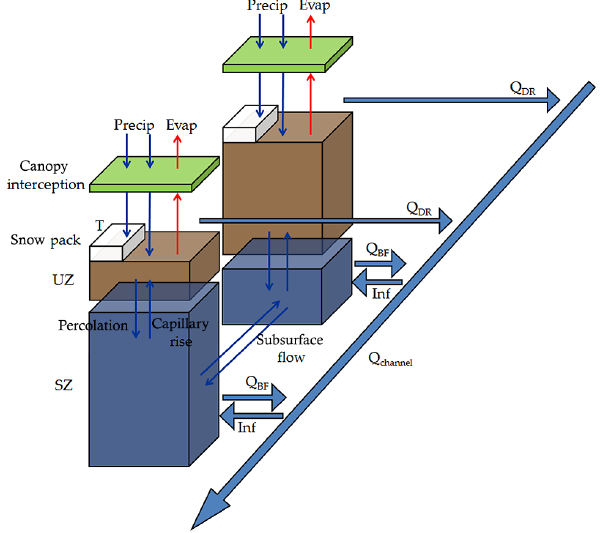
Figure 2. OpenStreams wflow_sbm model structure, adapted from Vertessy and Elsenbeer (1999) and Schellekens (2014). Symbols’ definitions are as follows: Precip, precipitation; Evap, evaporation; T , temperature; UZ, unsaturated zone; SZ, saturated zone; Qchan- nel, total runoff; QDR, direct runoff; QBF, baseflow; and Inf, water flow from the river channel to the saturated zone. ( ∼ 1 km × 1 km) with daily temporal resolution. A schematic